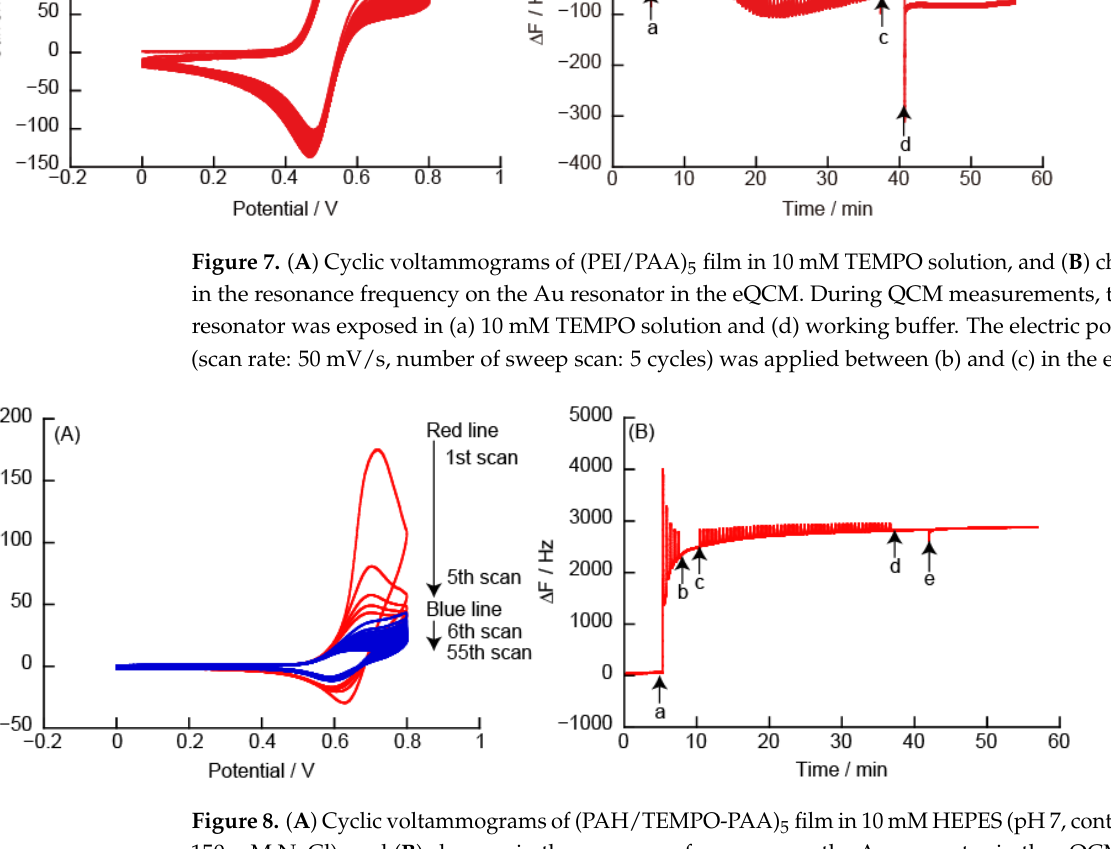
Figure 8. ( A ) Cyclic voltammograms of (PAH/TEMPO-PAA) 5 film in 10 mM HEPES (pH 7, contain- ing 150 mM NaCl), and ( B ) changes in the resonance frequency on the Au resonator in the eQCM. The electric potential (scan rate: 50 mV/s) was applied between (a) and (b) (number of sweep scan: 5 times), or (c) and (d) (number of sweep scan: 50 times) in the eQCM. Finally, the Au resonator was exposed to 10 mM HEPES buffer (pH 7, containing 150 mM NaCl) (e). 3.2.3. CVs and eQCM Measurements Obtained from (PDDA/TEMPO-PAA) 5 Film- Coated Electrodes PDDA is a high charge density cationic polymer with quaternary amines. Figure 9 shows CVs and eQCM measurements obtained from the (PDDA/TEMPO-PAA) 5 film- coated Au electrode. The CVs show Ep a at +0.6 V due to the oxidation reaction of TEMPO in the (PDDA/TEMPO-PAA) 5 film. At Ep a in the 1st scan, ΔF from the eQCM measure- ments increased due to the oxidation reaction of the (PDDA/TEMPO-PAA) 5 film. In the